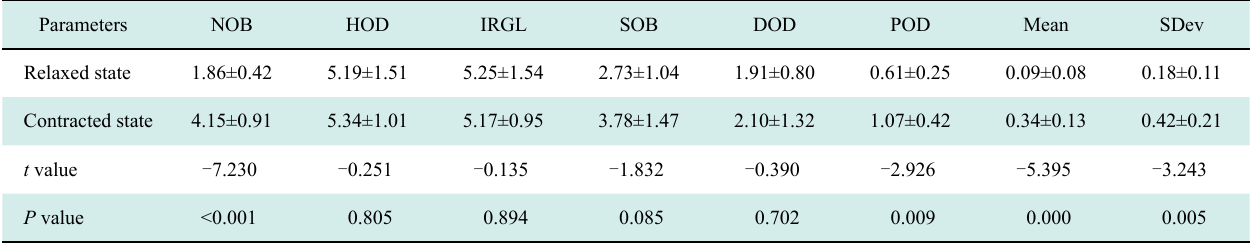
Table 3 Eight texture features of biceps brachii in female healthy volunteers under relaxation and contraction ( x ± s , n =30 samples) Parameters